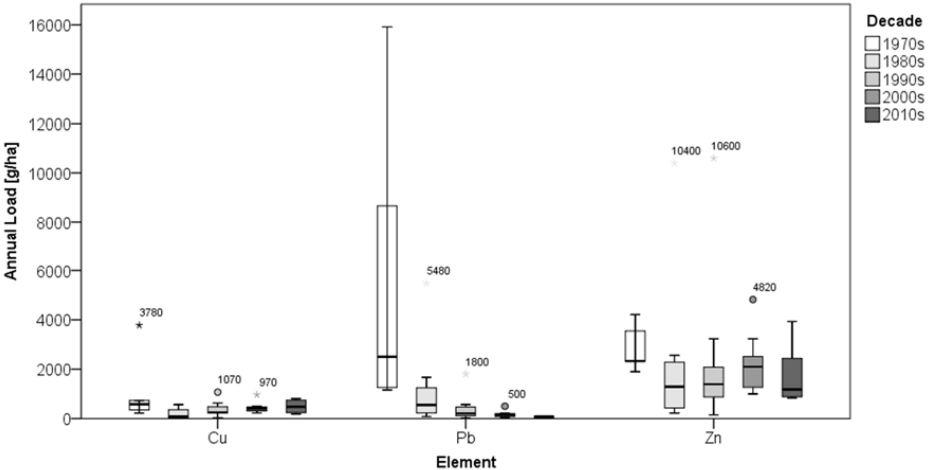
Figure 2. Historical trends of Cu ( n = 41), Pb ( n = 42), and Zn ( n = 43) in traffic area runoff loads from the 1970s to date.